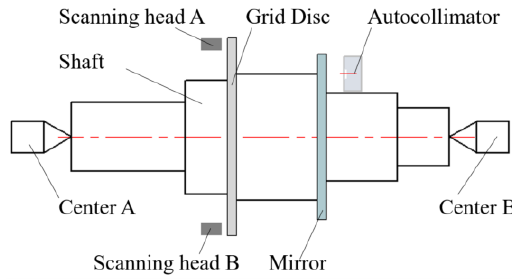
Figure 3. Measurement of assembly error.